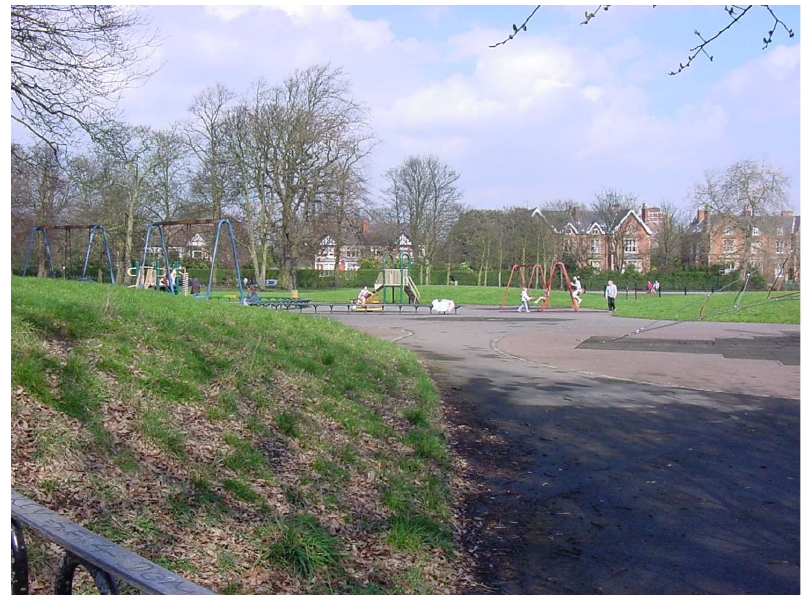
Figure 1. View of Birkenhead Park in 2015, a mixture of open space with a variety of active and passive uses, and periphery housing and structures within the park (copyright © 2005 Jon Bryan Burley, all rights reserved and used with permission).